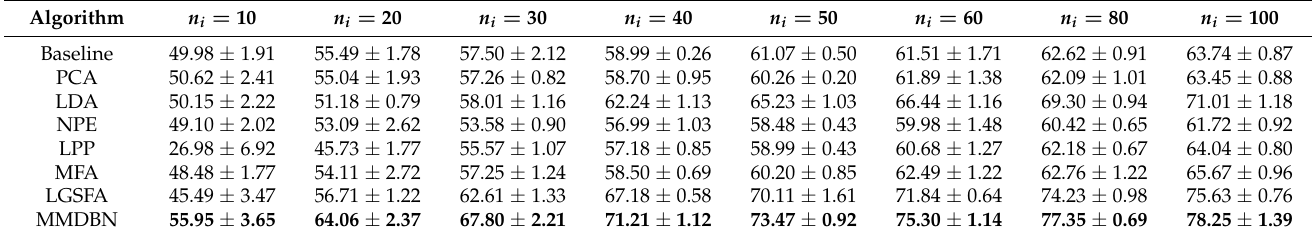
Table 1. The classification results of different DR algorithms for Indian Pines dataset (overall accuracy ± Std (%)).